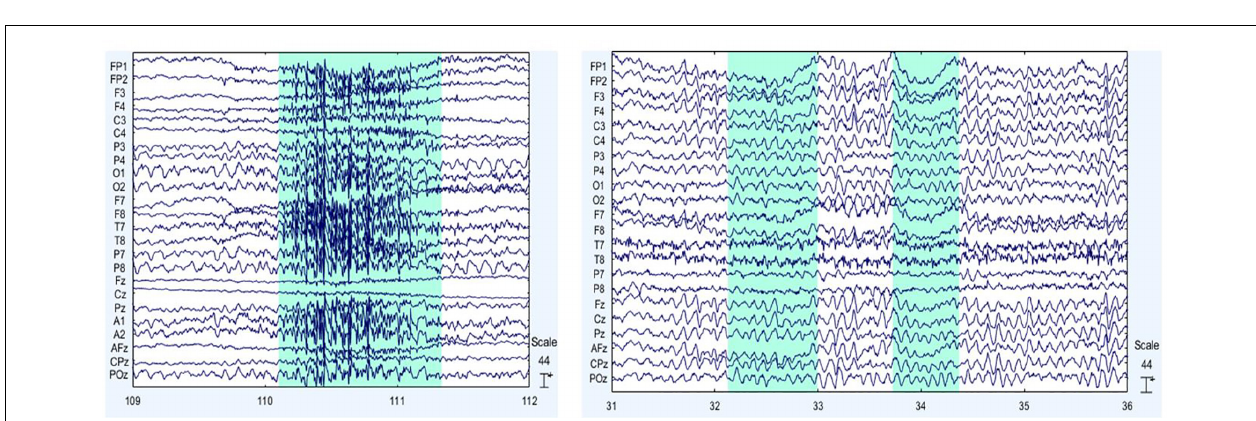
FIGURE 2 | Environment for Binaural Stimuli. The preparation stage in S1 was about 47 min long. For S2, it was about 21 min long since the procedure started at step 6 (sitting down the volunteer).